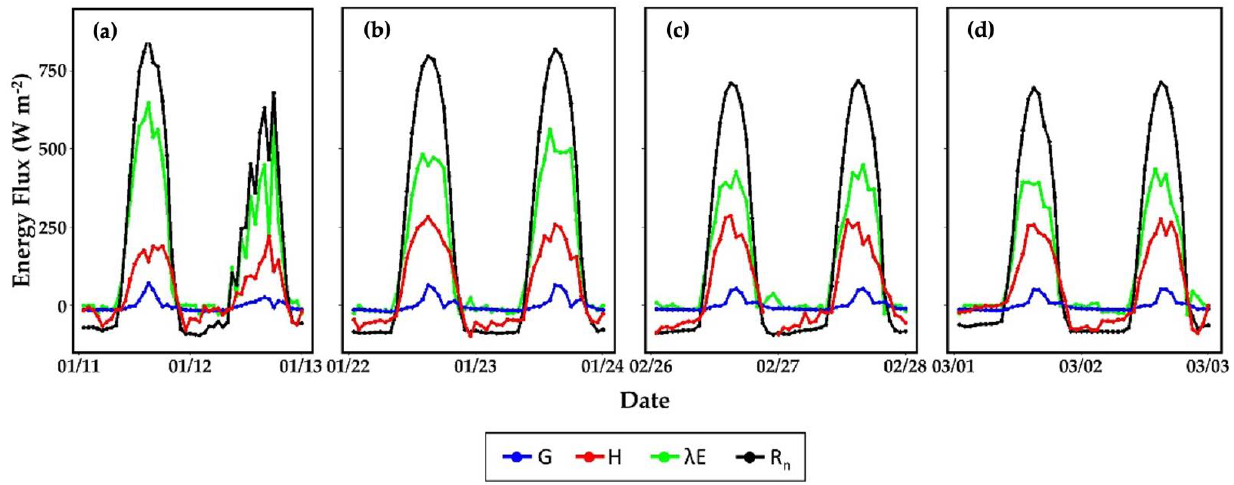
Figure 6. Diurnal trend of energy fluxes during four 2 – day periods at site 2 in 2019. The fluxes include soil heat flux (G), sensible heat (H), latent heat ( λ E), and net radiation (Rn). ( a – d ) represent the first, second, third, and fourth field campaigns, respectively.